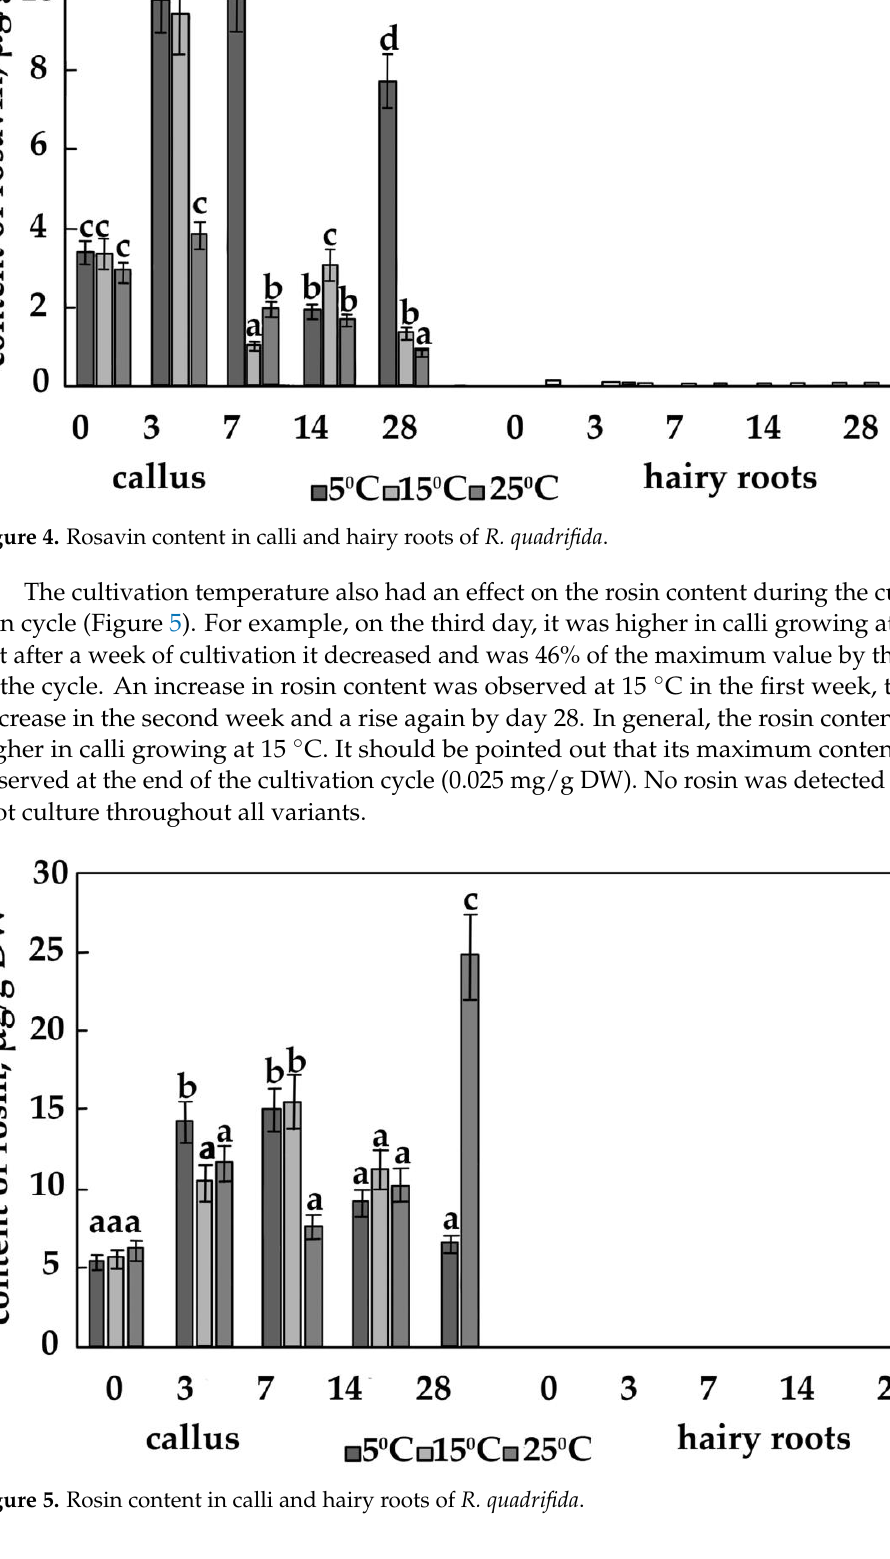
4.1. Features of In Vitro Growth of Rhodiola Quadrifida Cultures and Its Effect on the Content of